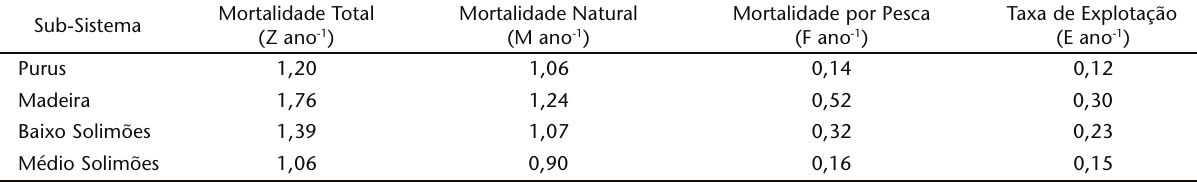
Tabela II. Estimativas de parâmetros populacionais para a matrinxã nos sub-sistemas Purus, Madeira, Baixo Solimões e Médio Solimões.